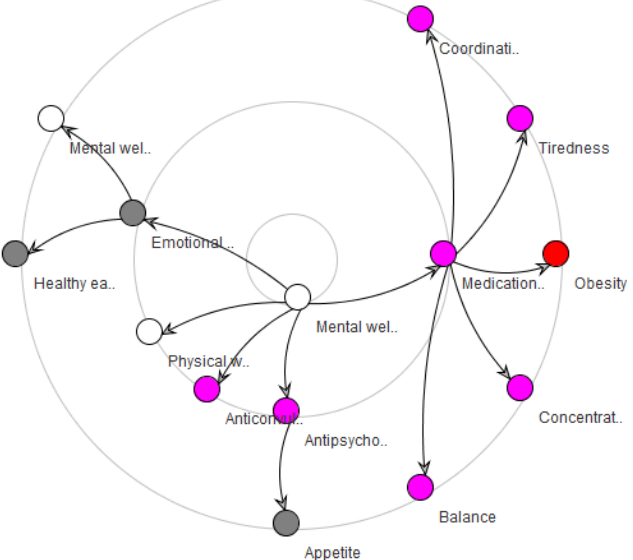
Figure 5. Policymakers can choose a specific factor as an intervention target, which will be placed in the center. The factors directly and indirectly affected by the intervention are organized in concentric circles by ActionableSystems . Factors that belong to different themes are shown in different colors (e.g., eating-related factors are gray).